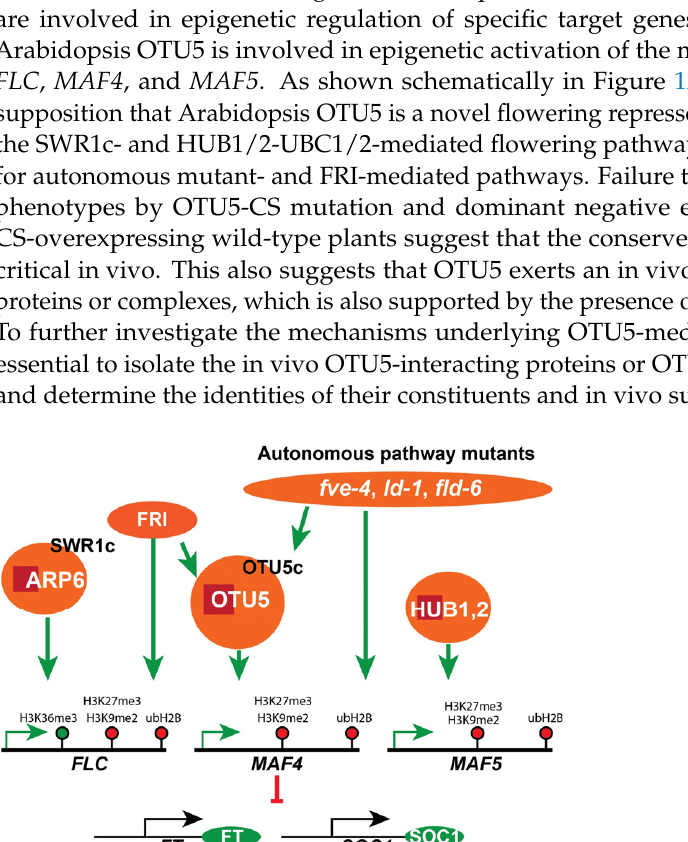
is indicated by green arrows, and transcription suppression is denoted by a red bar. Supplementary Materials: The following supporting information can be downloaded at: www.mdpi.com/xxx/s1. Author Contributions: Conceptualization, R.R. and H.F.; methodology, R.R., S.-Y.L., R.U., W.-D.L., G.-Y.J., W.S., and H.F.; validation, R.R., W.-D.L., W.S., and H.F.; formal analysis, R.R., W.-D.L., and H.F.; investigation, R.R., S.-Y.L., R.U., and H.F.; resources, G.-Y.J., W.S., and H.F.; data curation, R.R., W.-D.L., and H.F.; writing—original draft preparation, R.R. and H.F.; writing—review and editing, W.S. and H.F.; visualization, H.F.; supervision, H.F.; project administration, H.F.; funding acquisition, H.F. All authors have read and agreed to the published version of the manuscript. Funding: This research was funded by the Ministry of Science and Technology (MOST), Taiwan, MOST 105-2311-B-001-054 and Academia Sinica, Taiwan, AS-102-TP-B05. Acknowledgments: We thank Scott D. Michaels (Indiana University, Bloomington, IN) for provid- ing mutation information about ld-1 ; Ram Nivas Ahirwar, Shu-Jen Chou, Mei-Jane Fang, and Wann- Neng Jane, and Huei-Jing Wang (IPMB) for technical assistance; and Chen-Tuo Liao (Department of Agronomy, National Taiwan University) for statistical analyses. The Cryo-SEM and light micros- copy analyses were conducted with assistance from the staff of the Plant Cell Biology Core Lab, IPMB. The microarray experiments with the Agilent platform were conducted by the DNA Micro- array Core lab (IPMB). Conflicts of Interest: The authors declare no conflict of interest and the funders had no role in the design of the study; in the collection, analyses, or interpretation of data; in the writing of the manu- script; or in the decision to publish the results.